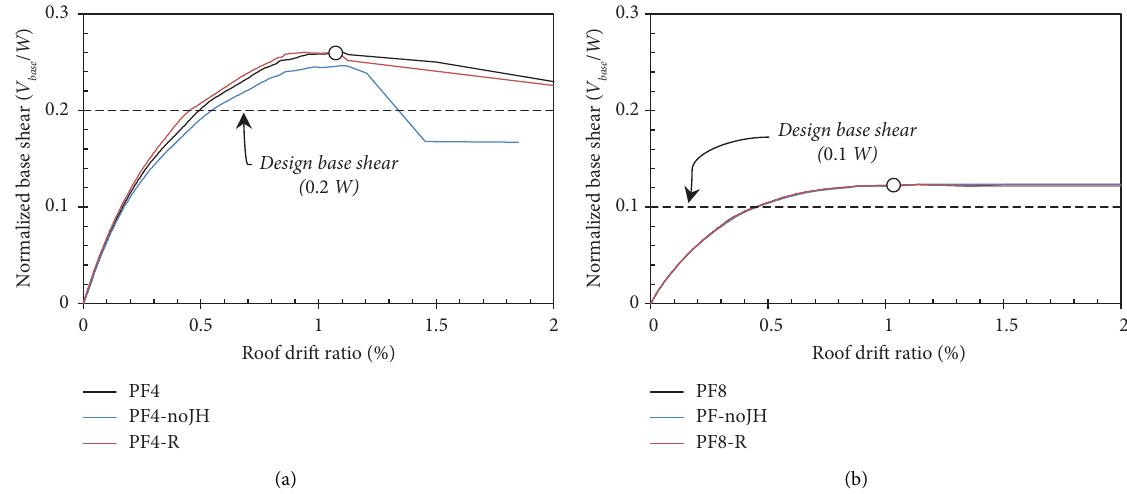
Figure 8: Pushover analysis results: normalized base shear with respect to roof drift ratio. (a) A four-story frame. (b) An eight-story frame.